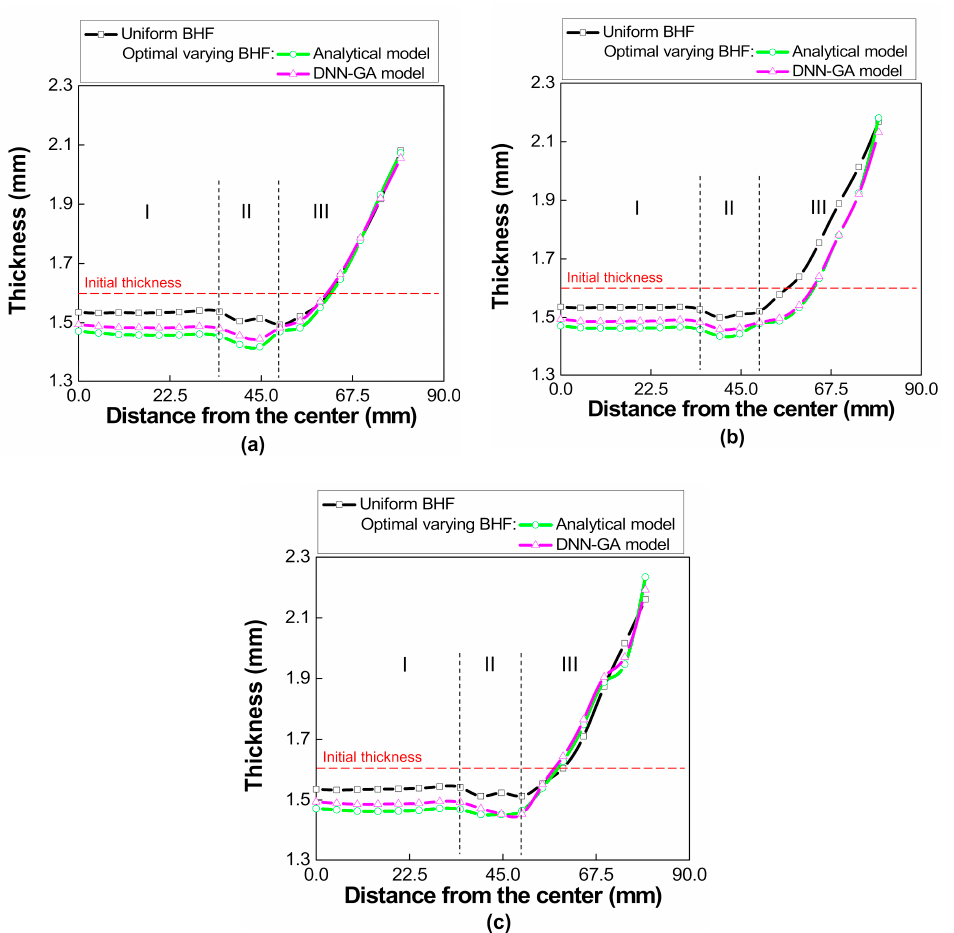
Figure 18. Thickness variations of the deep-drawn cup of AA1050-O along the ( a ) RD, ( b ) DD, ( c ) TD at different regions in a comparison between uniform and optimal varying BHFs obtained by the analytical and DNN-GA models.